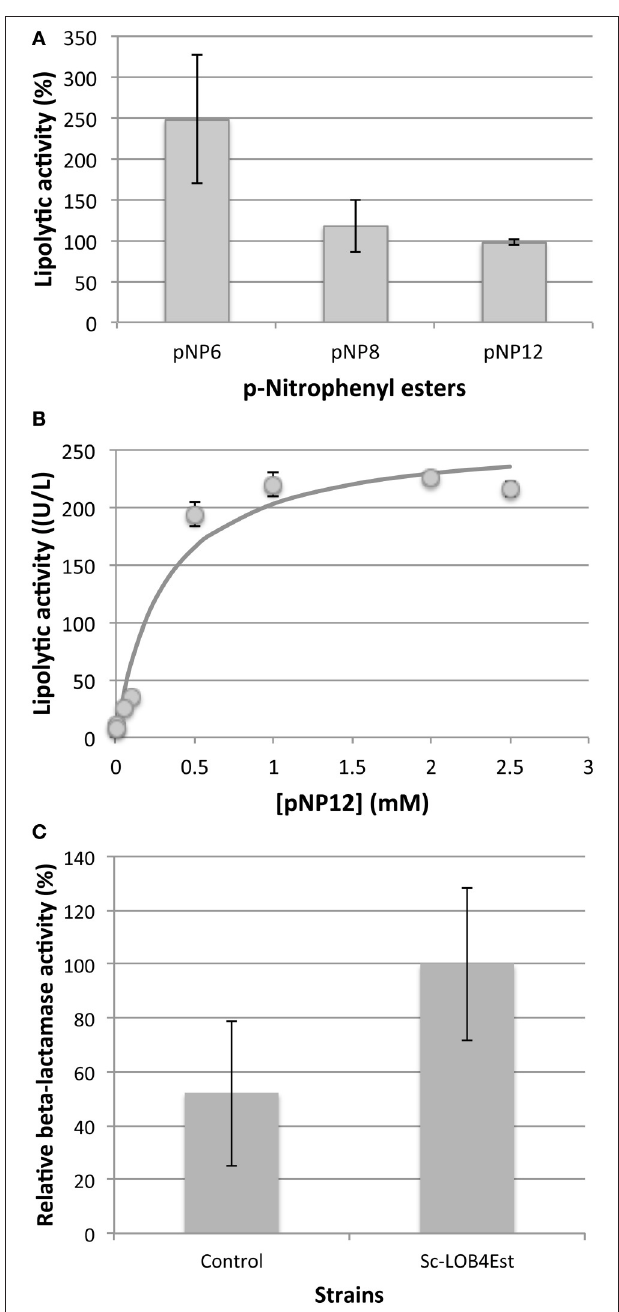
FIGURE 8 | Biochemical characterization of LOB4Est: Substrate preference (A) and Michaelis-Menten kinetics using pNP12 as substrate (B). Data show mean ± standart deviation. N = 3 . (C) Relative β -lactamase activity of extracellular medium from cultures of Sc-LOB4Est strain and control strain. Data show mean ± standard deviation. N = 3 .